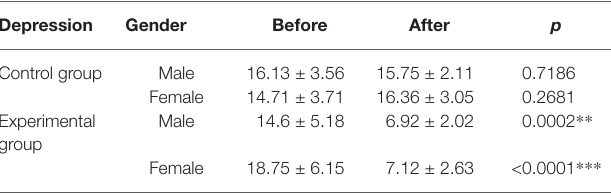
TABLE 2 | Gender differences of GIMT effect in two groups in depression.